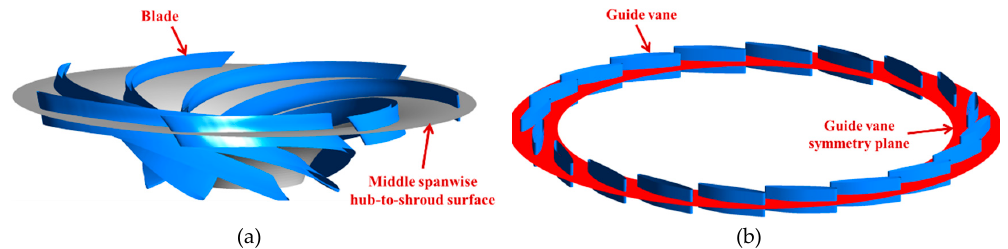
Figure 5. Static pressure monitoring points in the draft tube, the vaneless space, guide vane, and stay vane channels.